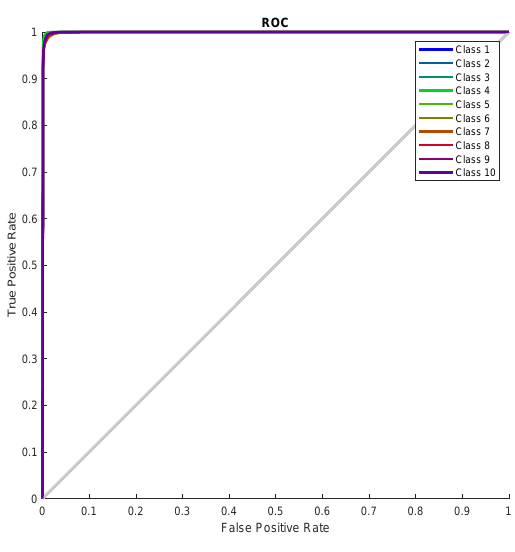
Figure 15. Receiver Operating Characteristic (ROC